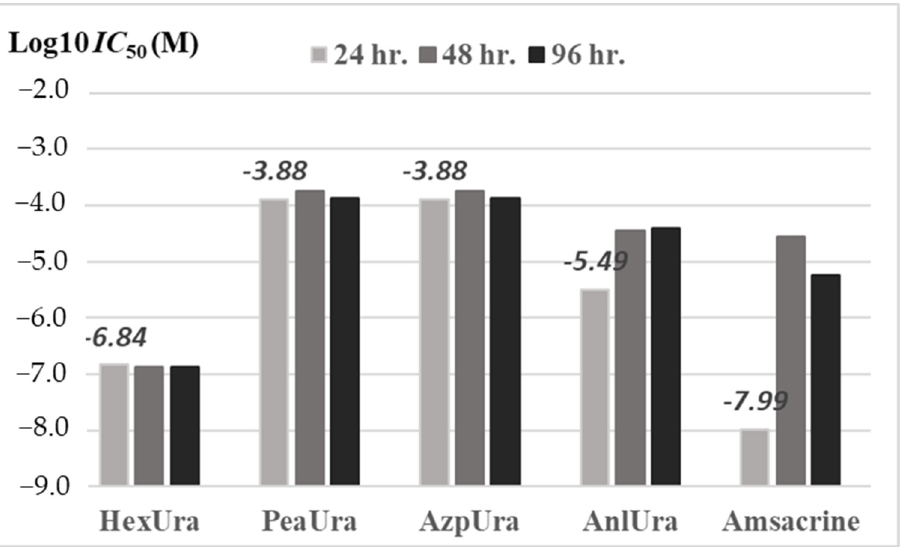
Figure 6. Decimal logarithm of the inhibition concentration (IC 50 ) of ureas 11b , 11c , 11f , 11j and amsacrine against immortalised foreskin fibroblasts (BJ-5ta) after 24, 48 and 96 h determined by real-time cell analysis and dynamic monitoring of cell proliferation. IC 50 values are given as a molar concentration.